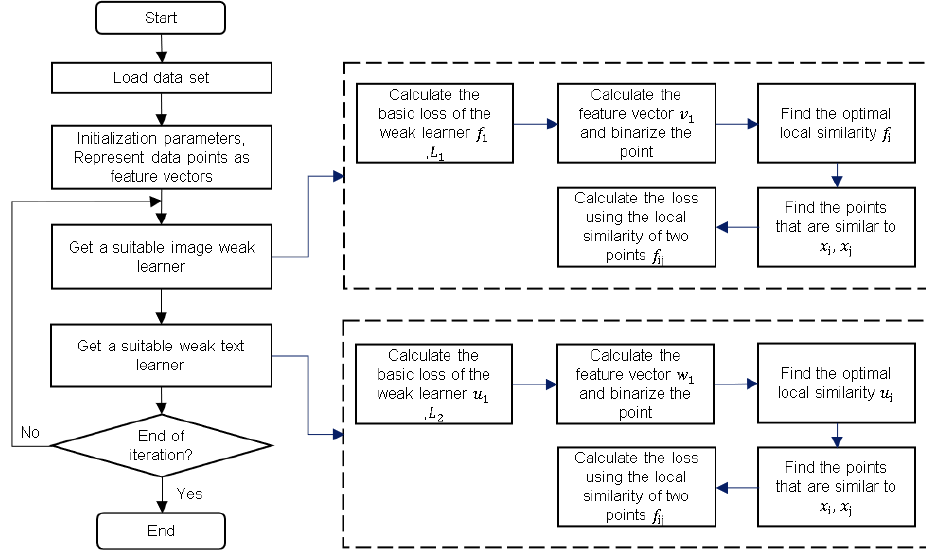
Figure 2. Algorithm flow chart.